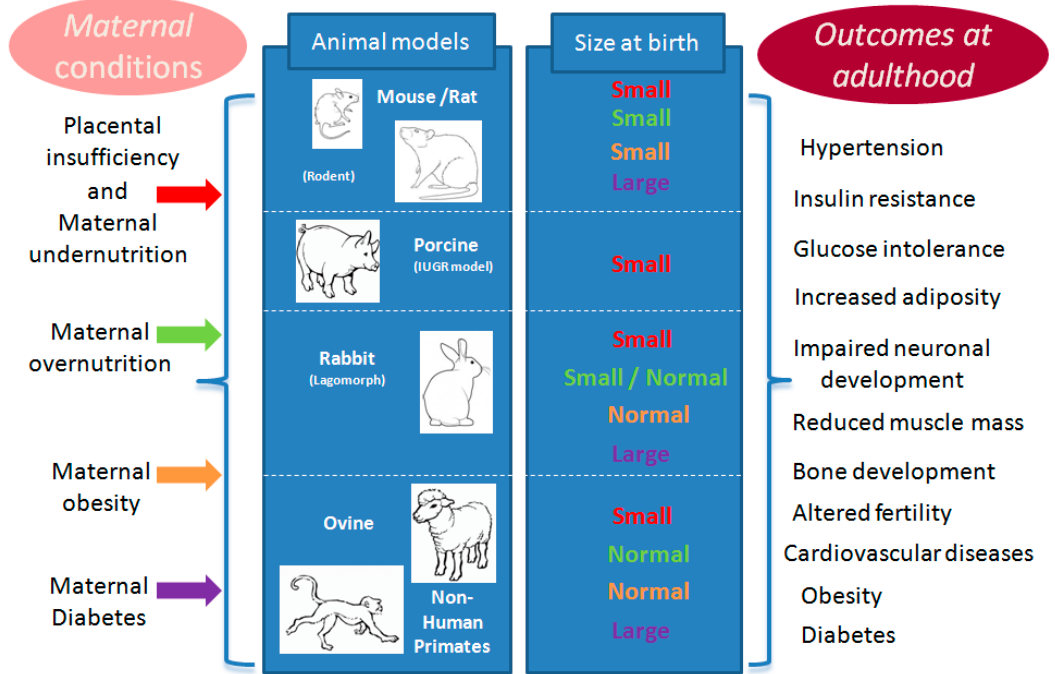
Figure 3. Schematic representation of prevalent models for studying exposures to maternal nutrition or metabolism during gestation, the consecutive and species-specific birth size, and the usual outcomes in terms of health for all animal models at adulthood. One color is attributed to each kind of exposure: red for placental insufficiency and maternal malnutrition (undernutrition), green for over nutrition, orange for obesity and purple for diabetes. The column “size at birth” gave the fetal response to each kind of maternal conditions in term of size compared to control conditions in the same species. The same color is used for the “small” or “normal” or “large” response to each corresponding maternal conditions compared to normal (or expected) size for same age in the same species.